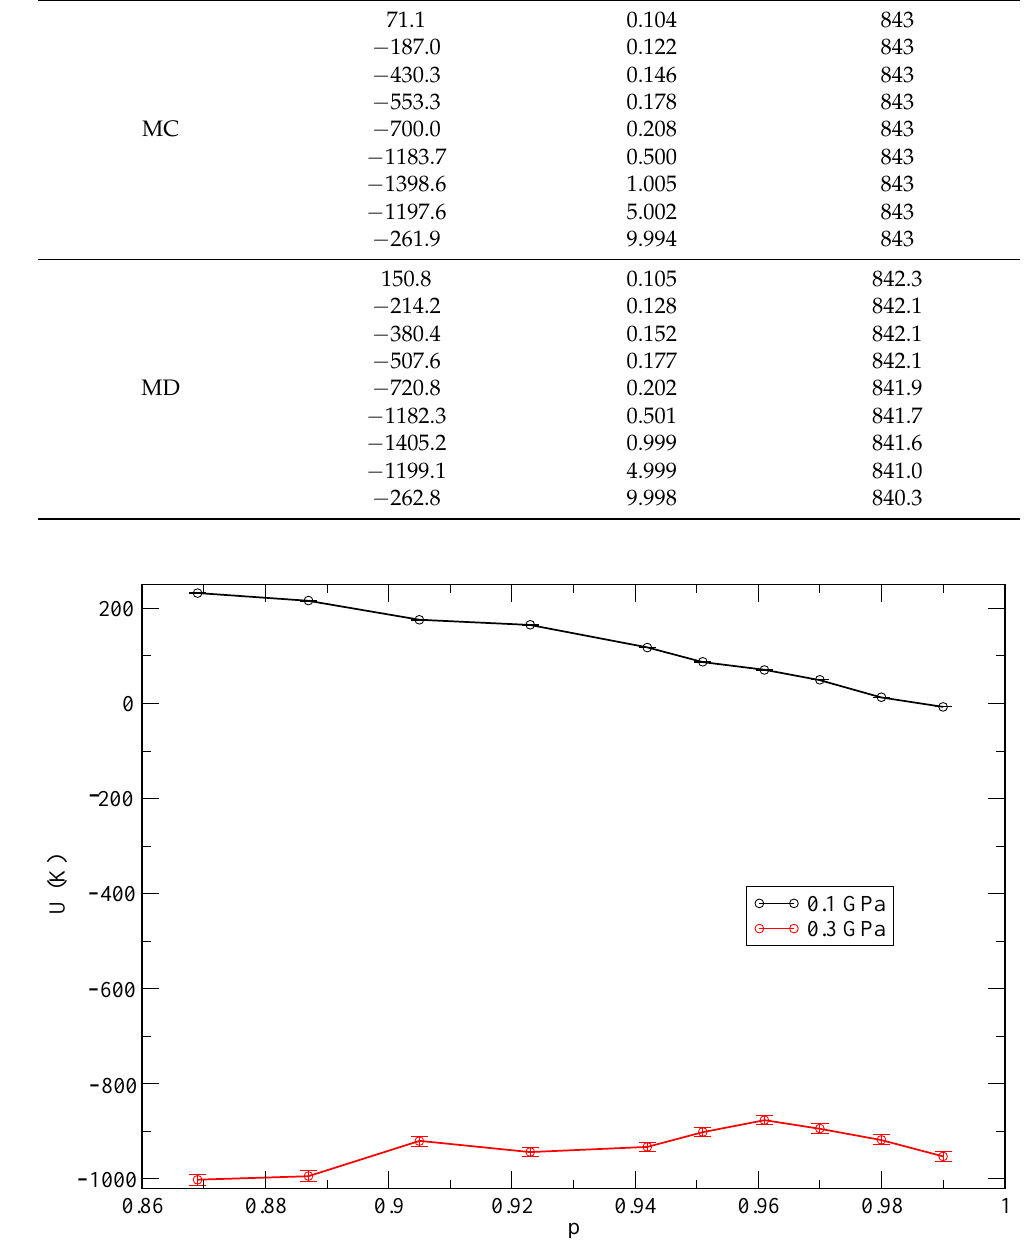
Figure 3. Total internal energies U as a function of concentration p for two characteristic pressures (0.1–0.3